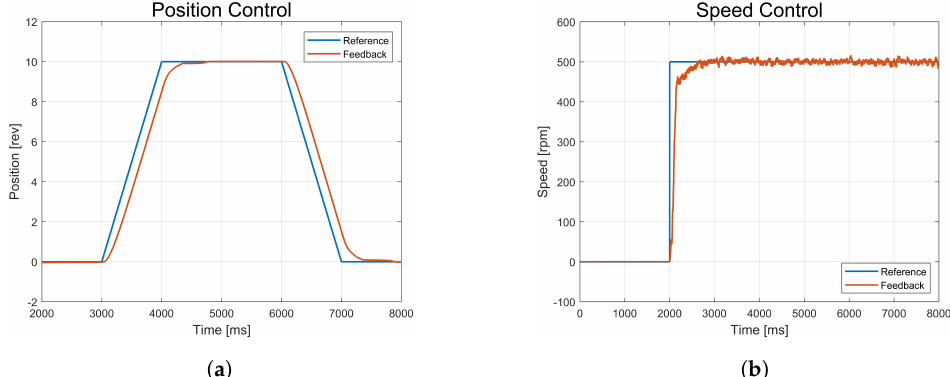
Figure 21. Motor control results. ( a ) Speed reference and feedback. ( b ) Position reference and